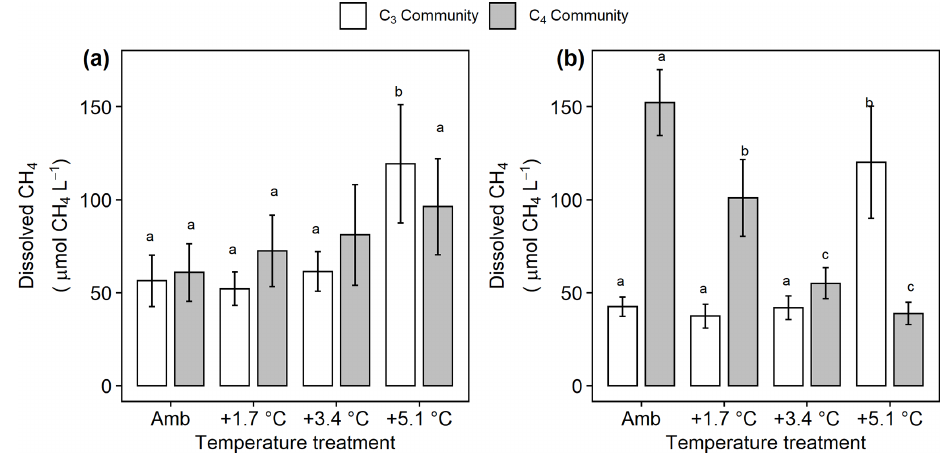
Figure 5. Comparison of dissolved CH 4 from the C 3 community dominated by Schoenoplectus (open bars) and the C 4 community dominated by Spartina and Distichlis (grey bars). (a) In the dominant rooting zone (10–20cm) and (b) below the rooting zone (40–120cm). Means are averaged across all sampling dates for 2016–2019. Error bars indicate SE. Letters indicate temperature treatments that are significantly different from each other ( p adj < 0 . 05) within the same plant community.